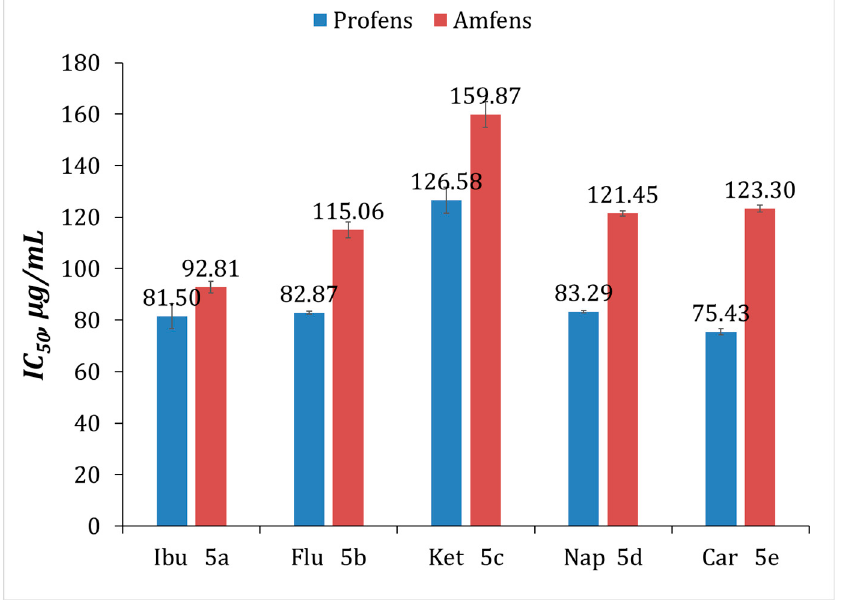
Figure 3. Inhibition of albumin denaturation (IAD) of profens and amfens 3a–e . As standards, anti- inflammatory medications, such as ibuprofen (Ibu), flulbiprofen (Flu), ketoprofen (Ket), naproxen (Nap), and carprofen (Car), were utilized. The results are presented as IC 50 (µg/mL) .